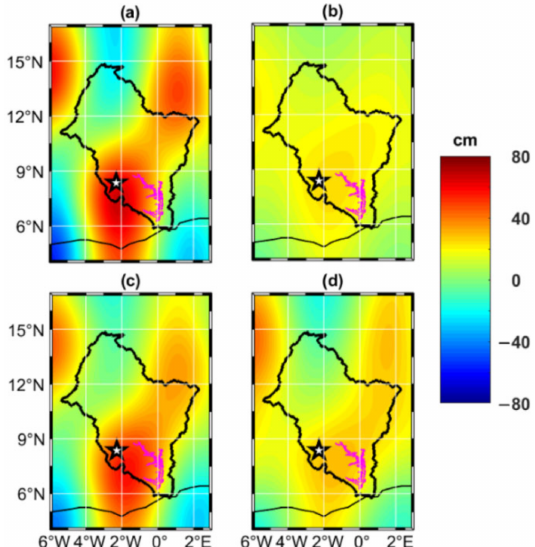
Figure 6. GRACE-observed mass changes between February and November in 2012 (Bui Reservoir impoundment). The raw ( a ) GRACE estimate is compared with ( b ) a 300 km Gaussian filtered GRACE estimate, ( c ) a DDK8 filtered GRACE estimate, ( d ) a combination of the decorrelation filter P4M6 and a 150 km Gaussian filter. The location of the Bui Reservoir is marked with a white star. The pink area represents the Volta